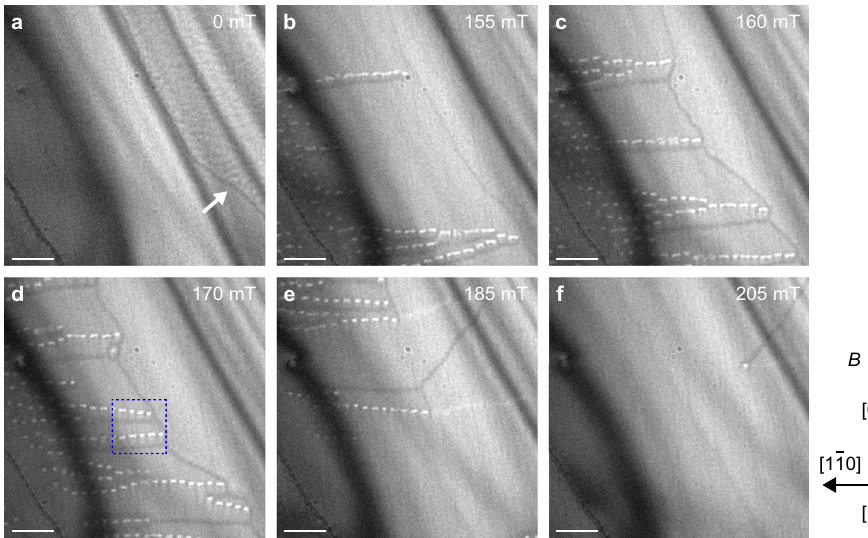
Fig. 2 Development of magnetic structures in the Co 8.5 Zn 7.5 Mn 4 (110) thin fi lm with t ~50nm. A series of underfocused LTEM images (defocus value Δ f = − 2 mm) obtained at 330 K and 0 mT ( a ), 155 mT ( b ), 160 mT ( c ), 170 mT ( d ), 185 mT ( e ), and 205 mT ( f ). The magnetic fi eld was applied perpendicular to the thin fi lm plane. The scale bars are 1 μ m. The strong dark line contrasts (the so-called bend contours) seen in the upper left to lower middle of each fi gure appear at locations where the Bragg condition is locally satis fi ed due to sample bending. Further details are displayed in Supplementary Figs. 1, 2. The blue dotted box in d corresponds to Fig.